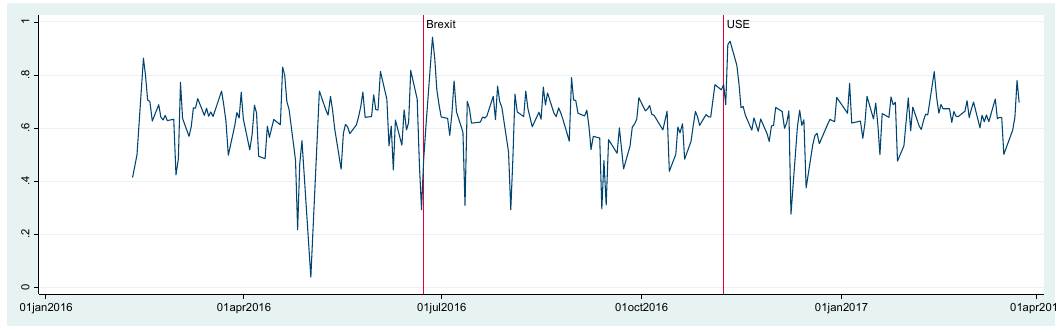
Figure 3. DCC coefficients.